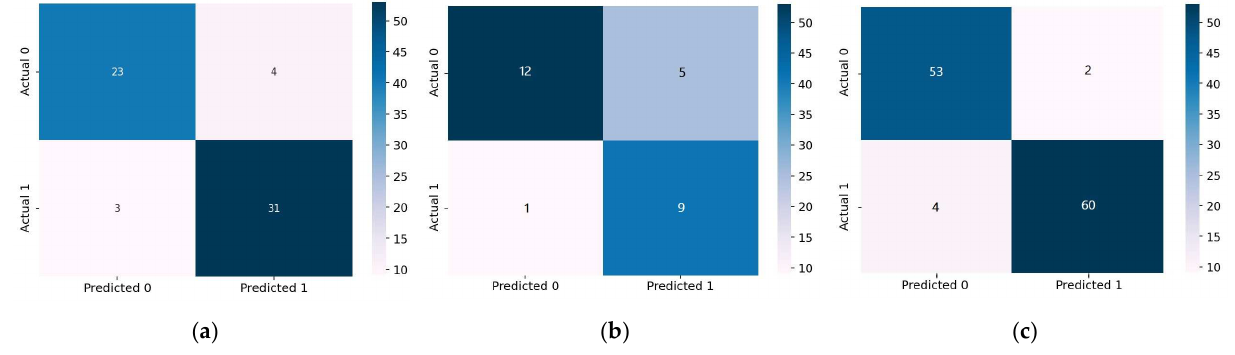
Figure 11. AUC measures of the Bi-LSTM model. ( a ) Cleveland dataset; ( b ) Statlog dataset; ( c ) Comprehensive dataset.